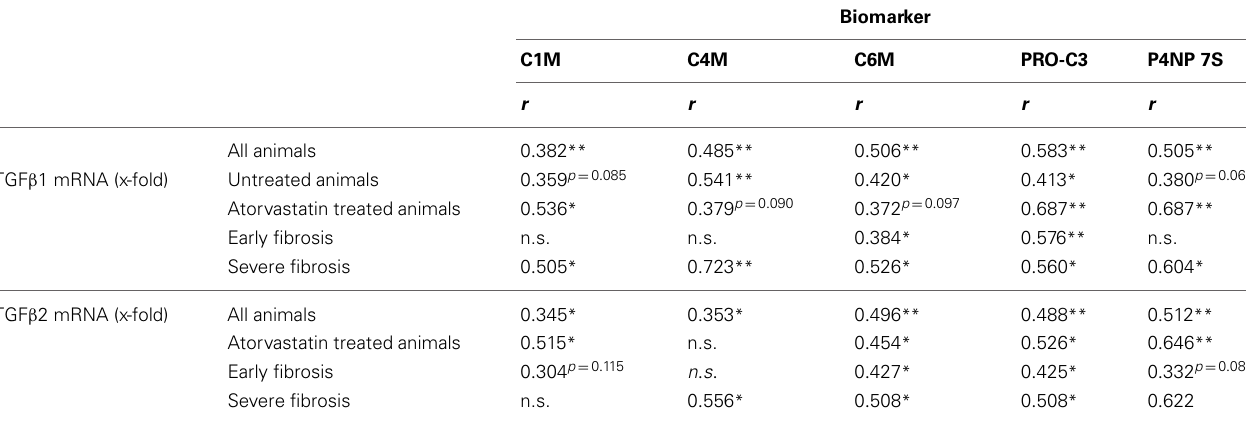
Table 4 | Correlations of mRNA levels from profibrotic cytokines with ECM